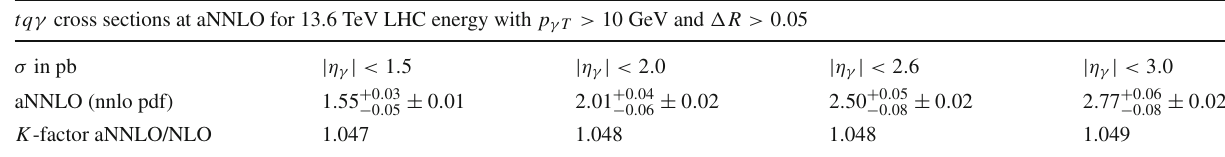
√ S = 13 . 6 TeV, with m t = 172 . 5 GeV and MSHT20 NNLO pdf